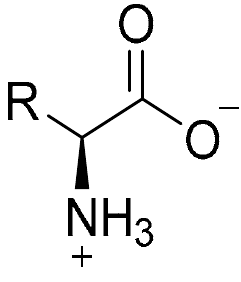
Figure 11. Zwitterionic structure of amino acids.